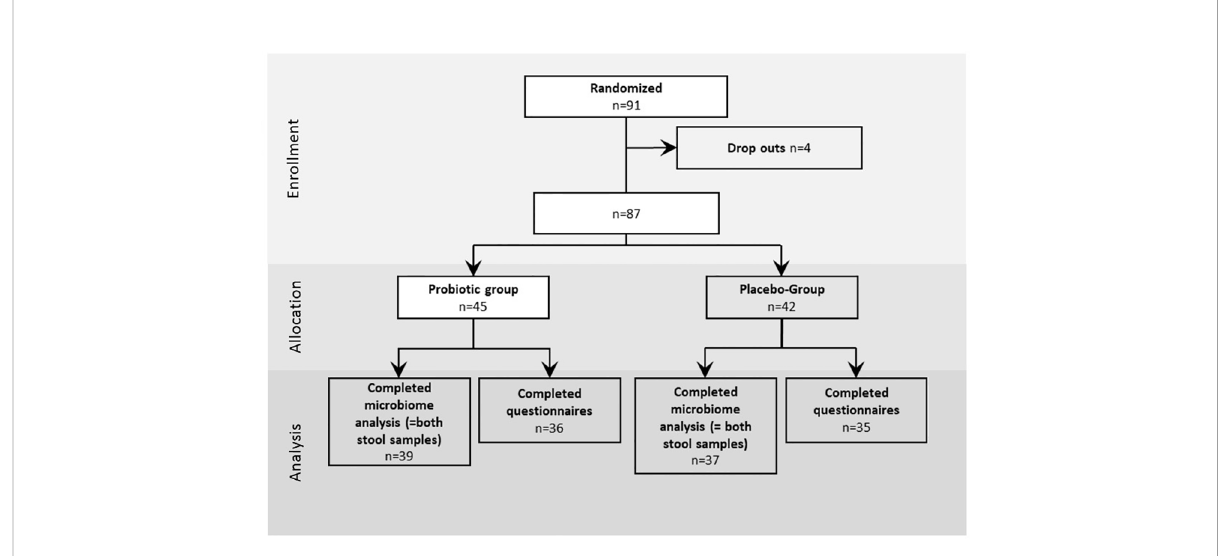
FIGURE 1 Study design: Enrollment, allocation and analysis of proband questionnaires data and stool samples of the study. The intervention was performed for 30 days after colonoscopy, the questionnaires was performed for 28 days.